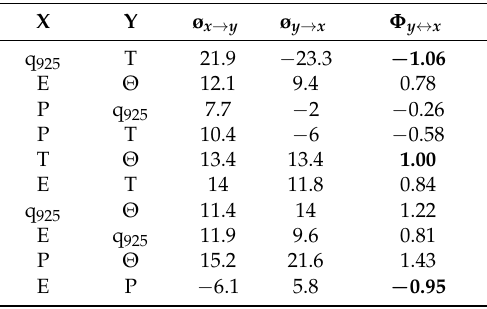
Table 3. Estimated values of simultaneous (no-lags) relative causality, τ (%), and feedback Φ y ←→ x for the highest ENSO-related covariance modes for all pairs of